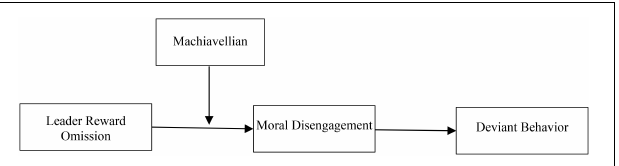
FIGURE 1 | Theoretical model of hypothesized